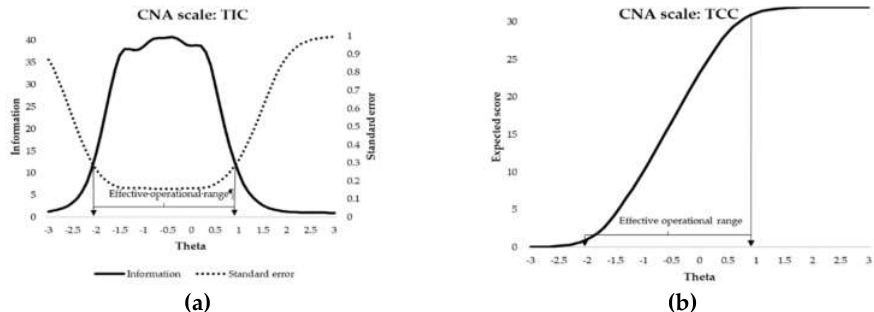
Figure 2. CNA scale: (a) test information curve and standard error; (b) Test characteristic curve. CNA = Community and neighborhood activities.